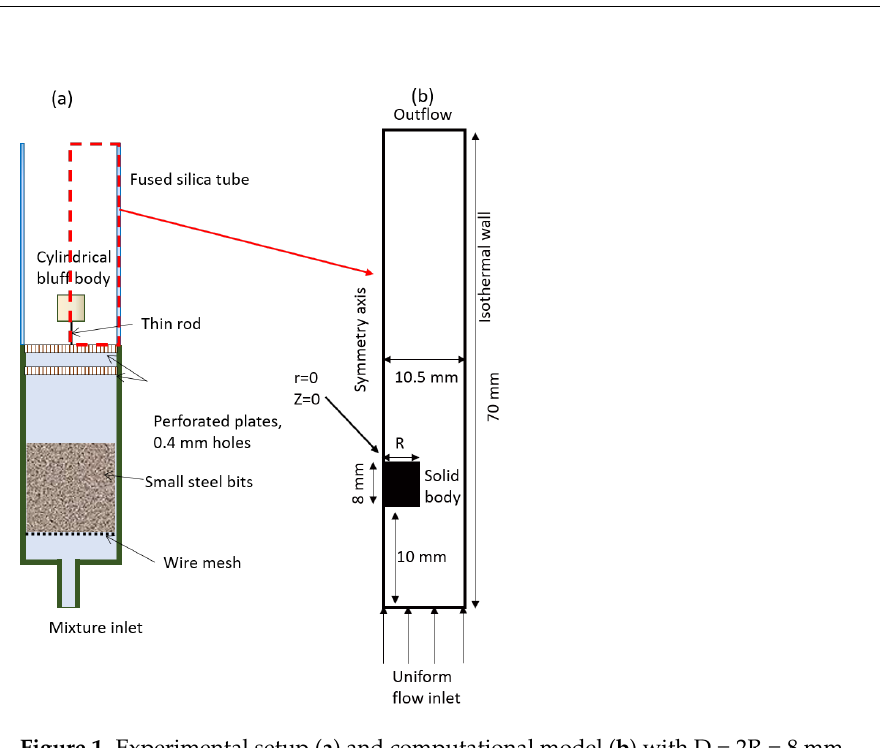
Figure 1. Experimental setup ( a ) and computational model ( b ) with D = 2R = 8